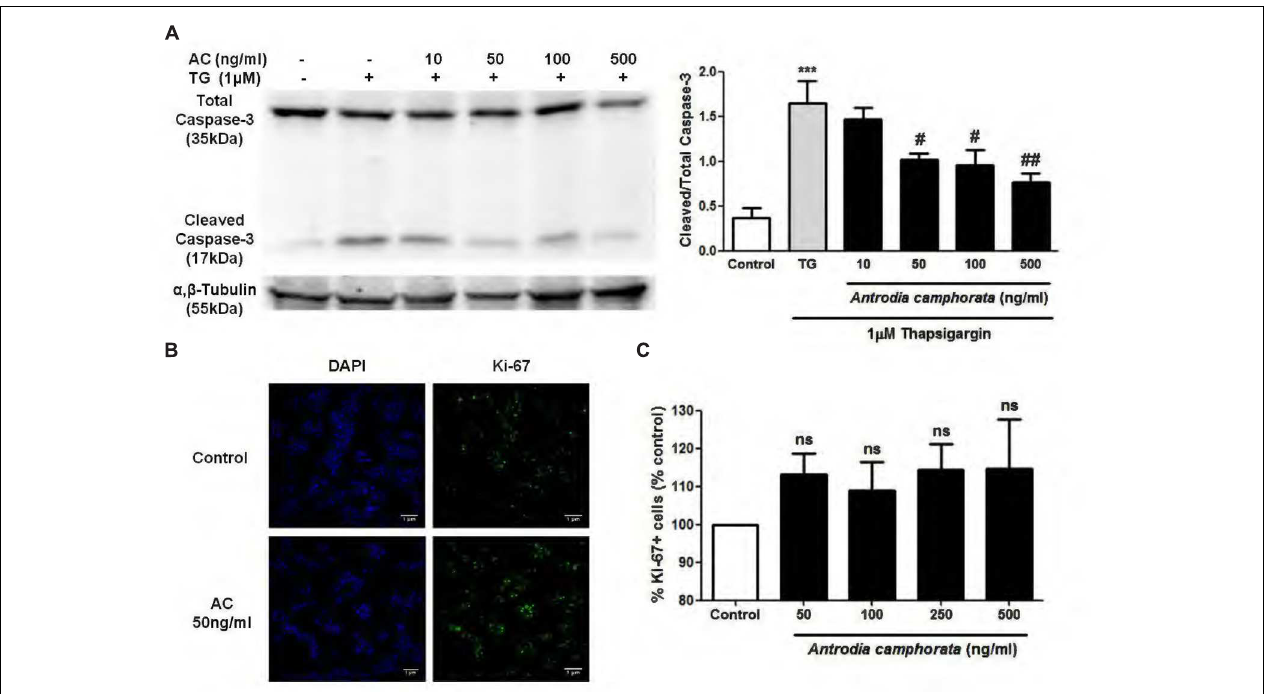
FIGURE 4 | Antrodia camphorata decreased caspase-3 expression and slightly increased cell proliferation in MIN6 cells. (A) Immunoblots and representative graphs showing the protein expressions of cleaved/total caspase-3. The cells were treated with A. camphorata (AC; 10–500 ng/ml) for 24 h and then stimulated with 1 µ M TG for 24 h, n = 4. ∗∗∗ P < 0.001 vs. control; # P < 0.05 , ## P < 0.01 vs. TG. (B,C) Images and representative graphs showing ki-67 staining. The cells were treated with 50–500 ng/ml A. camphorata for 24 h, n = 4. Results were expressed as mean ±